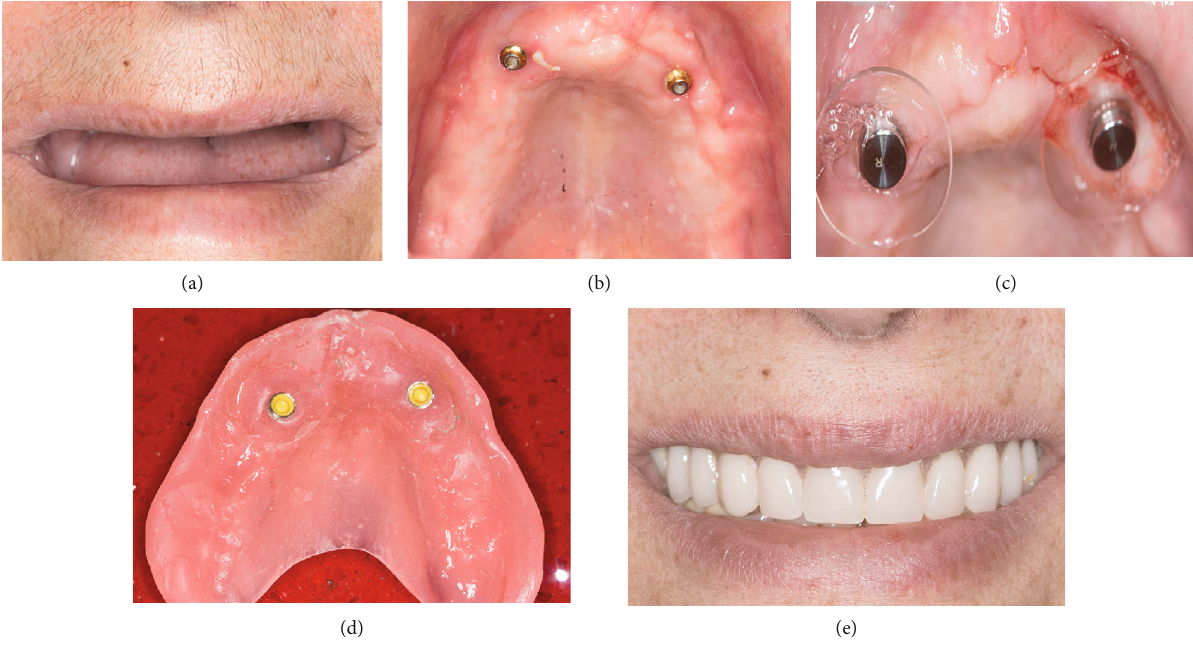
Figure 4: Temporization, 2-3 weeks following right hemimaxilla segmental resection: (a) maximum smile showing the successfully eliminated gingival display. (b) Occlusal view of the healed maxilla with two protruding implant overdenture attachments. (c) Respective housings mounted over the overdenture attachments to be picked-up in the denture intrados by a relining procedure. (d) Denture ready to be seated over the attachments. (e) Patient new smile with the retained denture in the mouth.